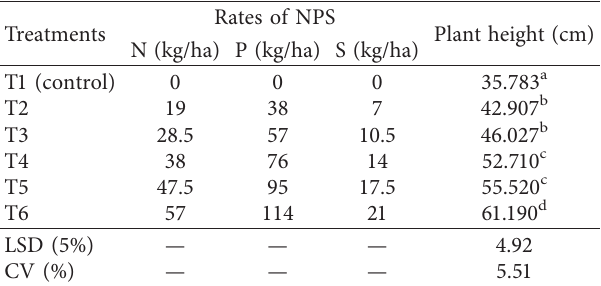
Table 5: Effect of different rates of NPS fertilizer on average bulb weight. Treatments